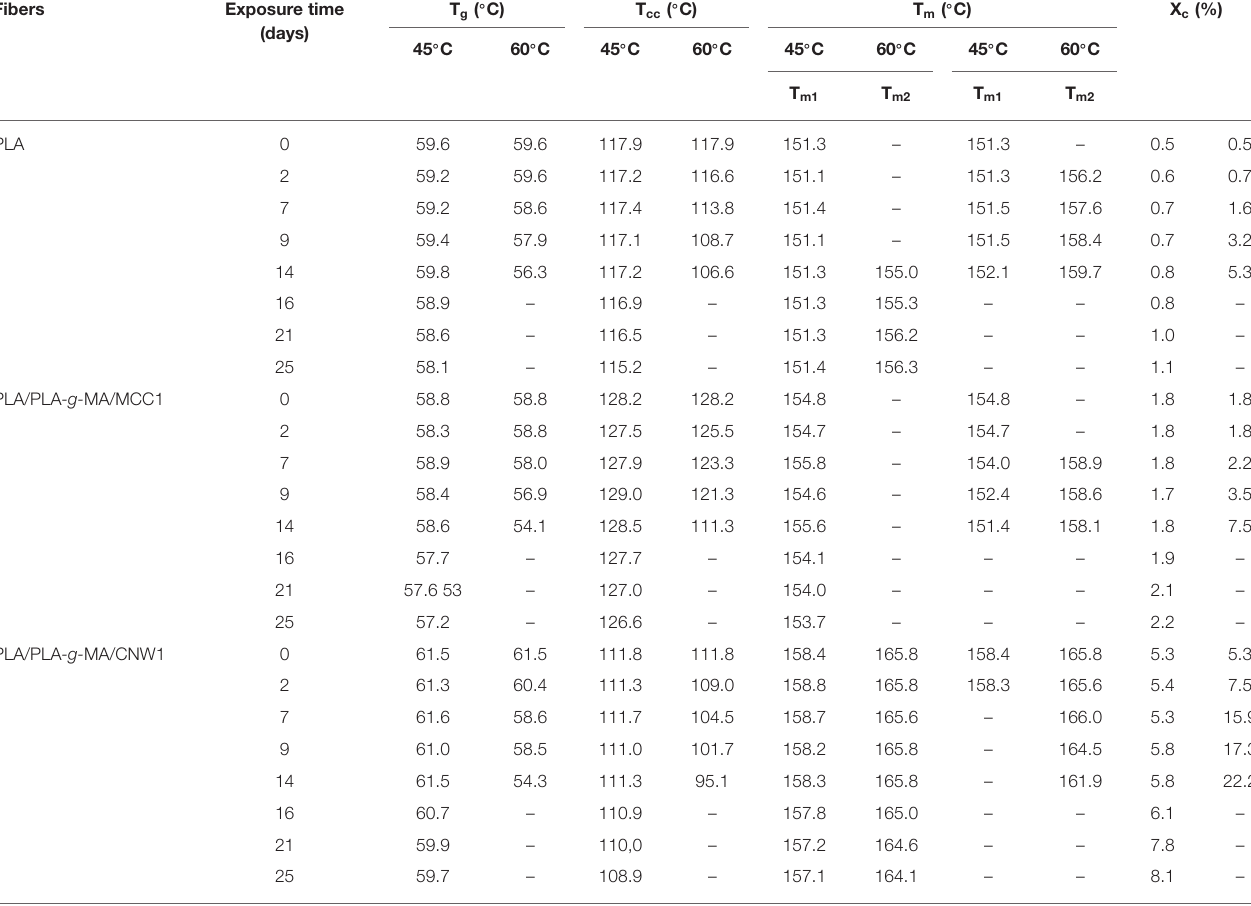
TABLE 4 | Thermal characteristics (T g , T cc , T m , and X c ) of PLA, PLA/PLA -g- MA/MCC1, and PLA/PLA -g- MA/CNW1 fibers recorded at 45 and 60 ◦ C in hygrothermal conditions. Fibers